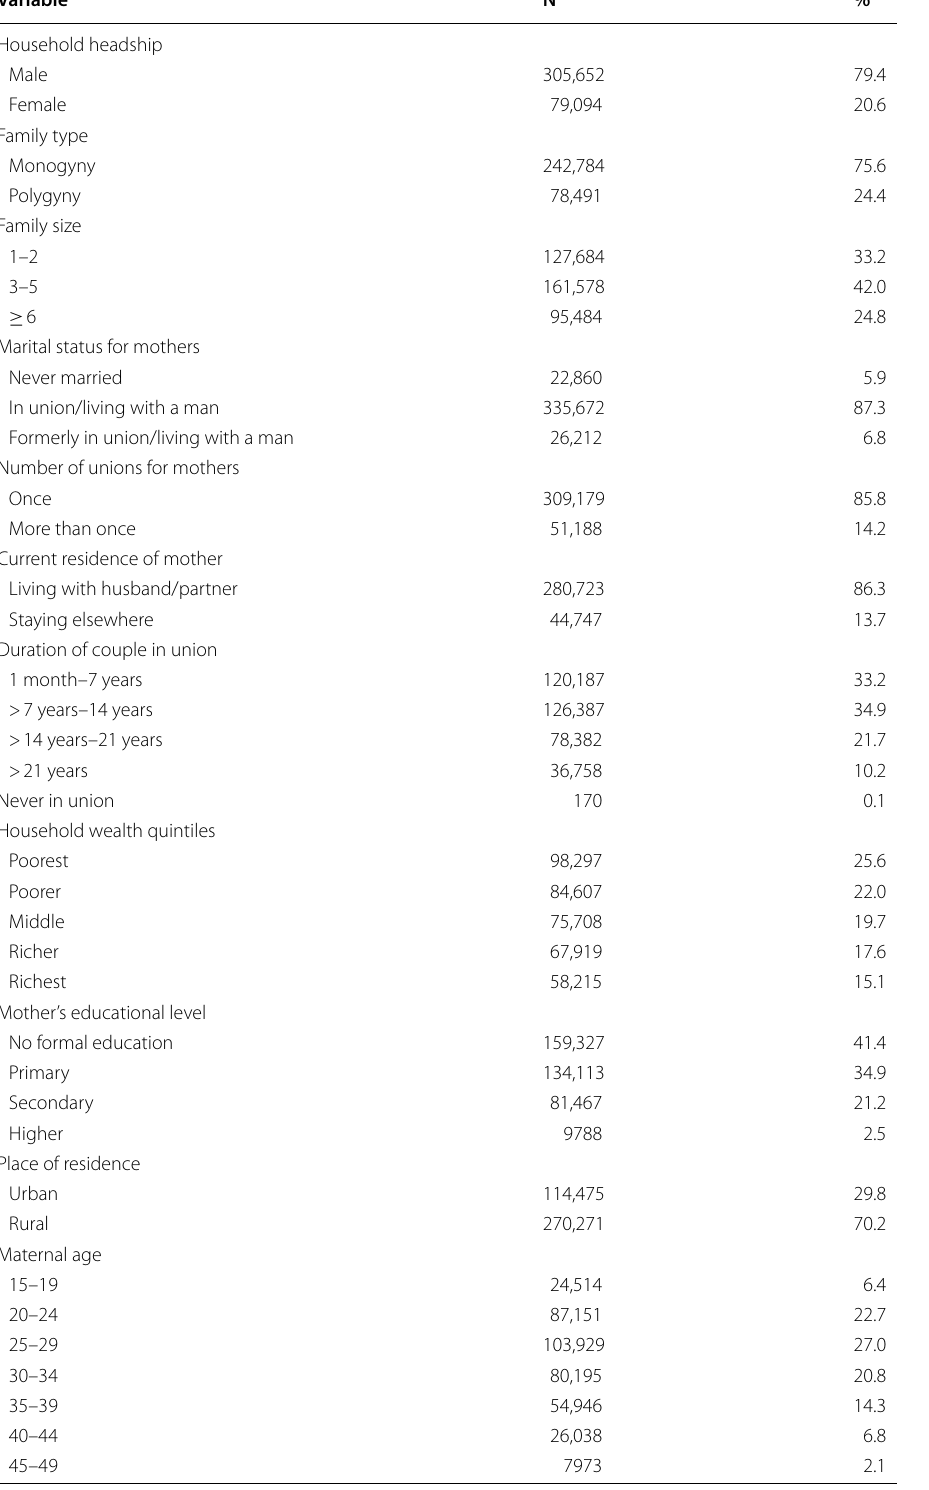
Table 2 Summary statistics for pooled data; DHS